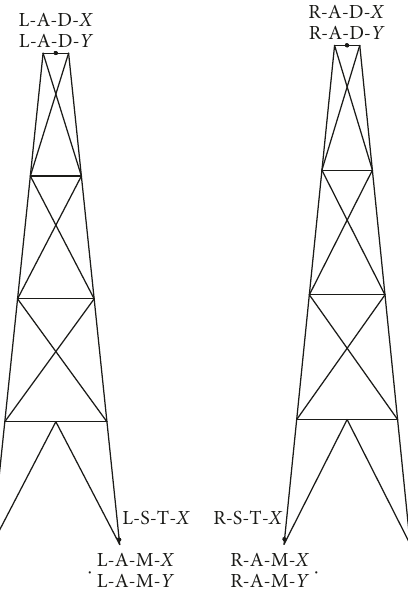
Figure 16: Layout of the accelerator sensors and strain gauges on the equivalent tower model.